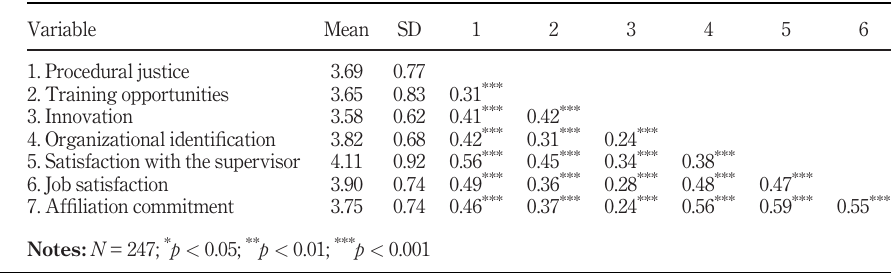
standard deviations and